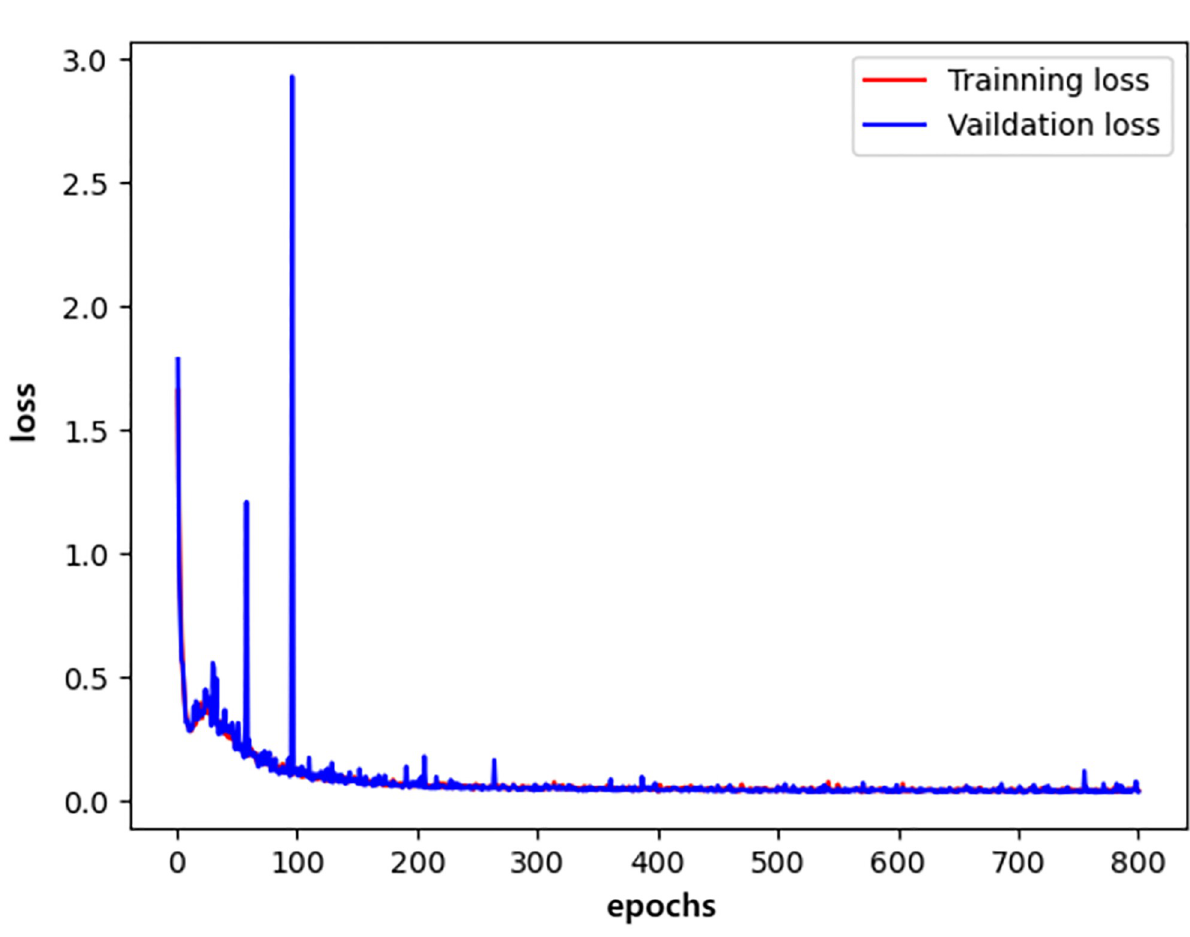
Fig 14. vgg16_loss.